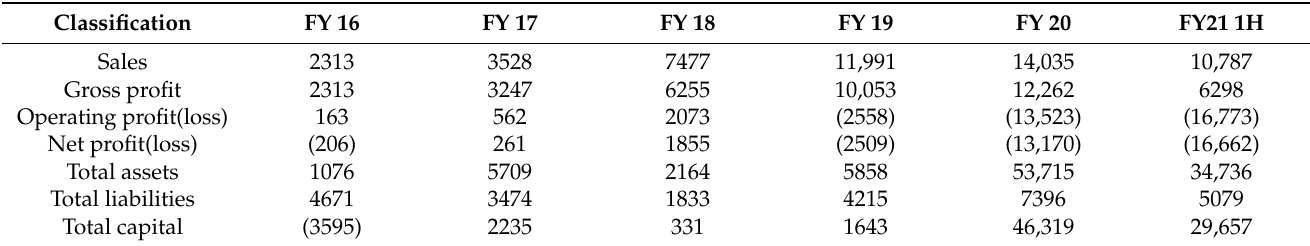
Table 3. The key financial statement of company